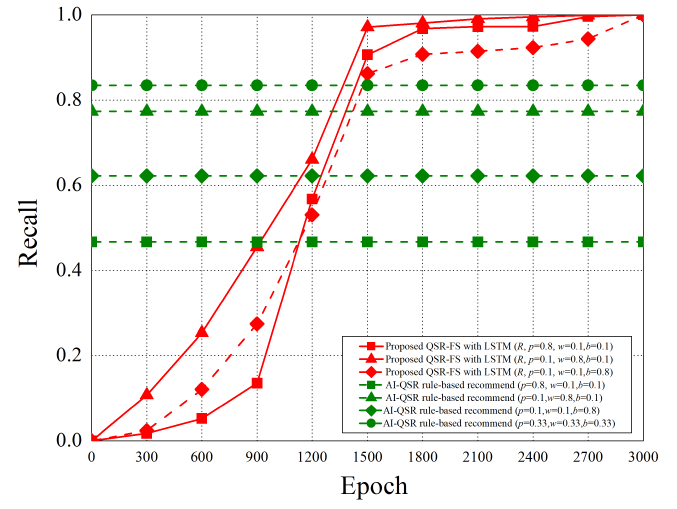
Figure 19. Recall vs. per epoch.